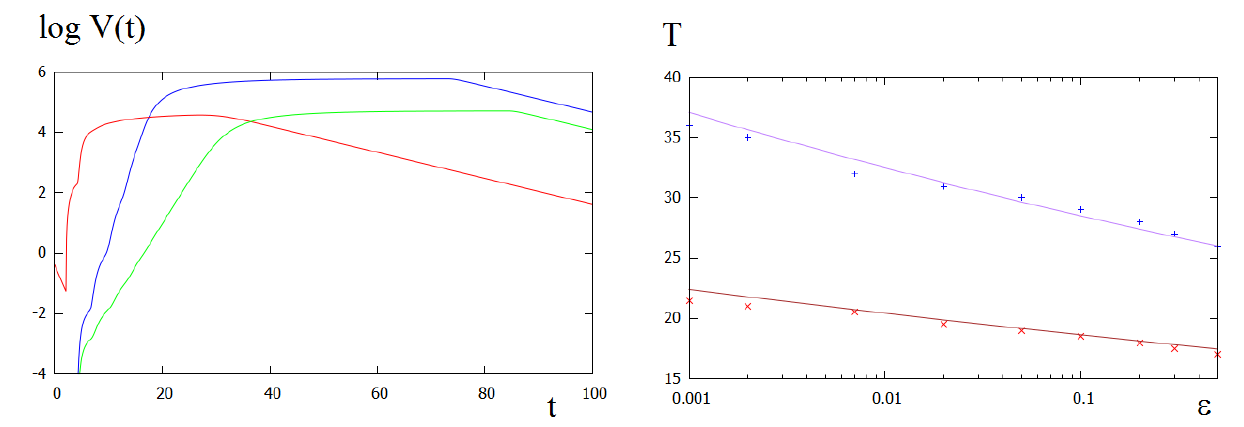
Figure 5. Left : V 1 ( t ) (red) and V 2 ( t ) (green) in the logarithmic scale for b 2 = 8 × 10 4 ; V 2 ( t ) (blue) for b 2 = 8 × 10 5 . Right : transition time T as a function of mutation rate (cid:101) for b 2 = 8 × 10 4 (upper curve, crosses) and b 2 = 8 × 10 5 (lower curve, crosses). Smooth lines represent analytical approximation with the functions p / (cid:101) q , p = 25, q = 0.057 (upper curve), p = 17, q = 0.04 (lower curve). The values of parameters: a 1 = 0.01, a 2 = 0.1, b 1 = 8 × 10 4 ; D 1 = D 2 = 10 − 3 , β 1 = β 2 = 0.1, σ 1 = σ 2 = 1, τ = 2, u 0 = 1, i 10 = i 20 = 0, v 1,0 = 4.5, v 2,0 = 0, x 0 =